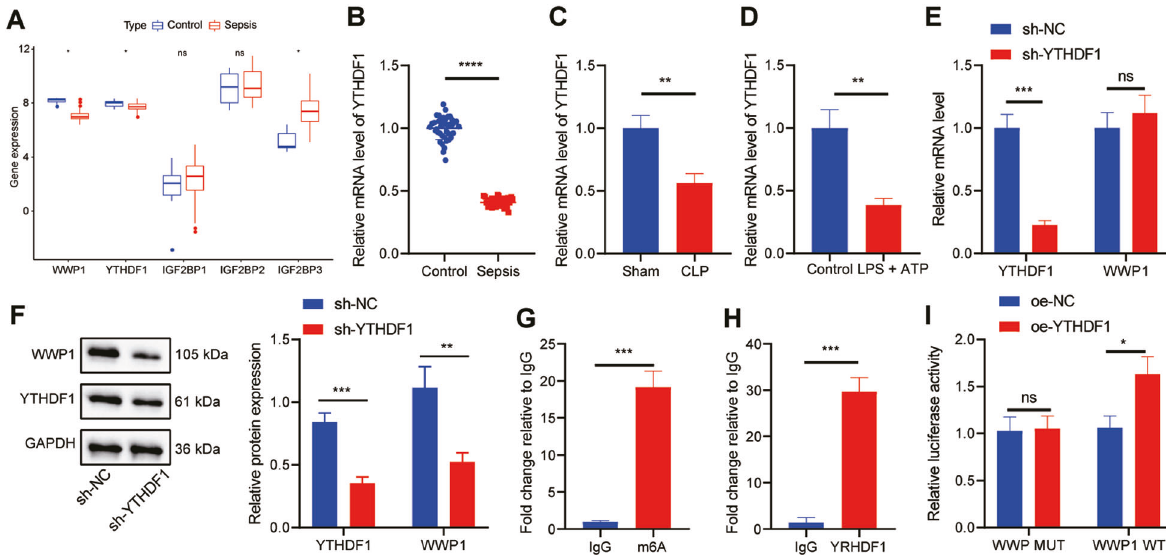
Fig. 3 YTHDF1 facilitates WWP1 expression in LPS + ATP-treated RAW264.7 cells. A The expression of WWP1 and four m6A readers in sepsis-related microarray GSE00159 (measurement data were expressed as mean ± standard deviation, and paired samples t test was applied for comparison between the control group and the sepsis group). B RT-qPCR to detect the expression of YTHDF1 in PBMCs of sepsis samples ( n = 40) and healthy controls ( n = 40). C The expression of YTHDF1 in PBMCs of mice with different treatment detected by RT-qPCR. D The expression of YTHDF1 determined by RT-qPCR. E The expression of YTHDF1 and WWP1 in cells with different treatment assessed by RT-qPCR. F Western blot assay to measure the protein expression of YTHDF1 and WWP1 in cells with different treatment. G The m6A modi fi cation status of WWP1 mRNA evaluated by meRIP. H, RIP-RT-qPCR to assess the binding of WWP1 mRNA to YTHDF1 protein. I Dual luciferase gene reporter assay to evaluate the binding of WWP1 and YTHDF1. There were 10 mice in each group. * p < 0.05; ** p < 0.01; *** p < 0.001. **** p < 0.0001. ‘ ns ’ indicates no signi fi cant difference. Cell experiments were repeated three